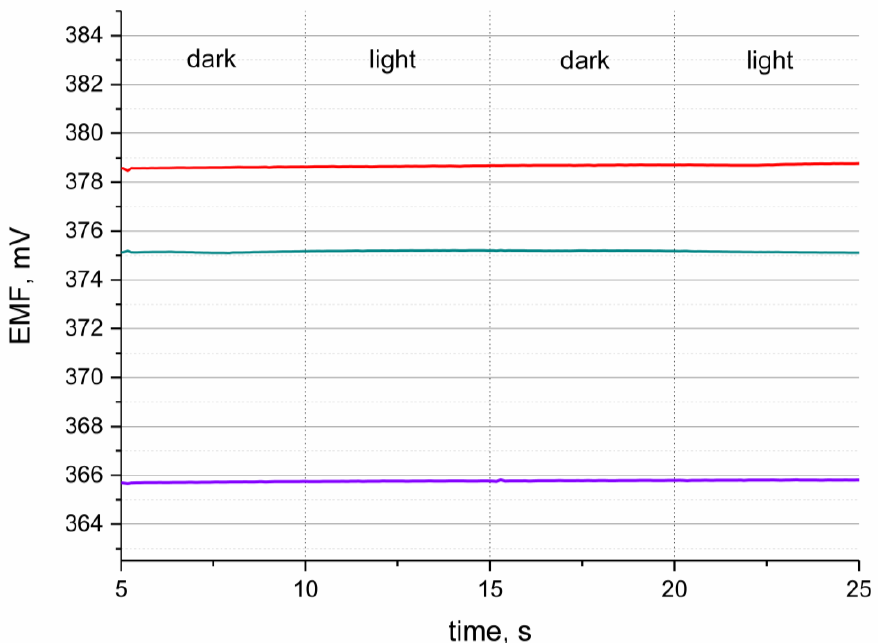
Figure 6. Light test conducted in the buffer solution of pH 2.5 for GC/hIrO 2 /H + -ISM (red line), GC/hIrO 2 +NTs/H + -ISM (green line), GC/hIrO 2 +NTs+POT/H + -ISM (purple line) and GC/H + -ISM (black line) electrode.